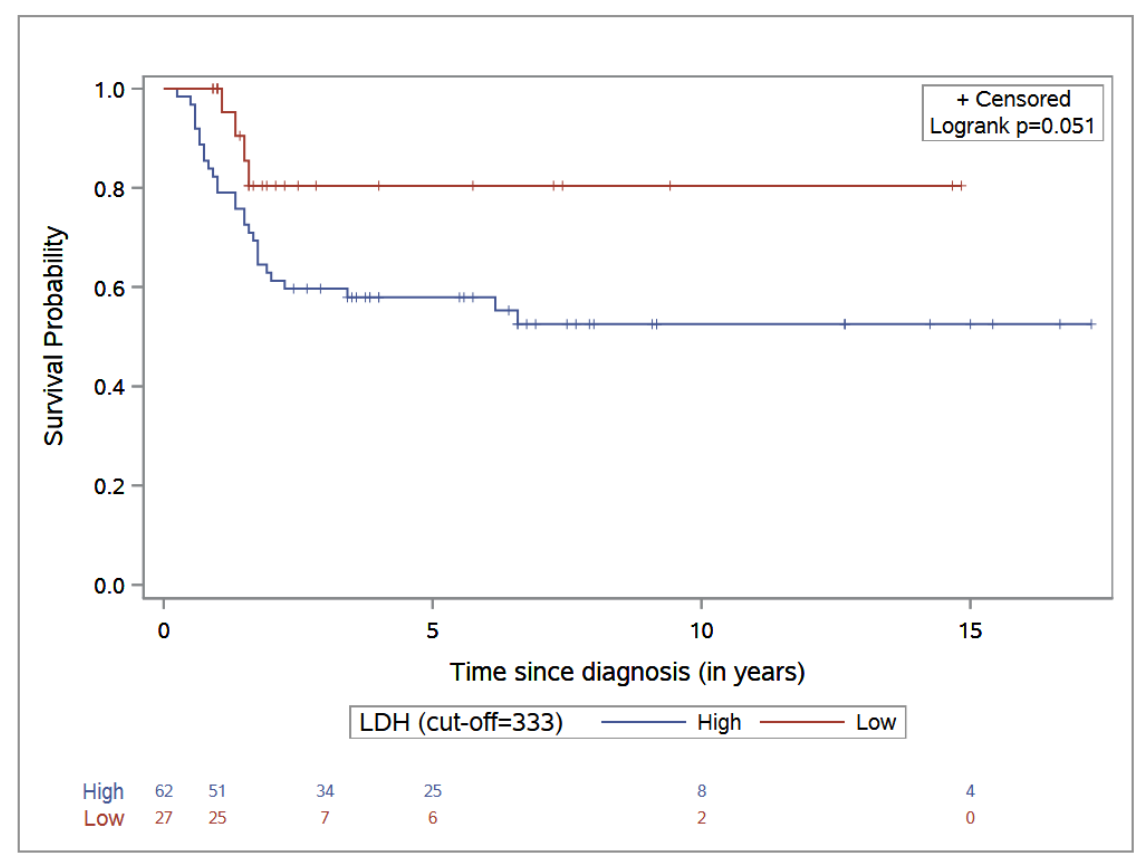
Figure 3. Progression-free survival stratified by LDH level.